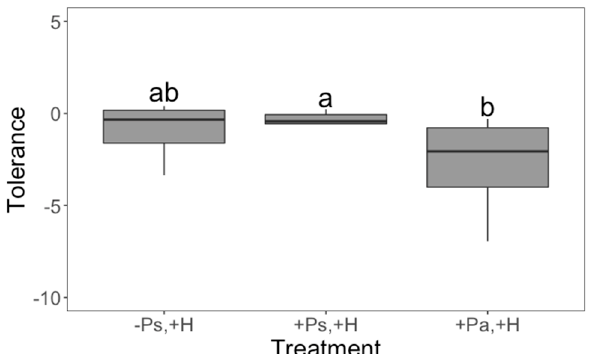
Figure 4. Effect of both priming (P) and herbivory (H) on tolerance. Boxplots representing the median, minimum and maximum values are shown. When plants were primed by an allopatric insect, the tolerance capacity was lower. Plus (+) and minus ( − ) signs denote the presence/absence of the treatment; Ps and Pa denote priming being performed by a sympatric or allopatric insect, respectively. Different letters denote significant differences following a Tukey–Kramer test ( p < 0.05). There were 24 replicates (plants) per treatment ( n = 72).